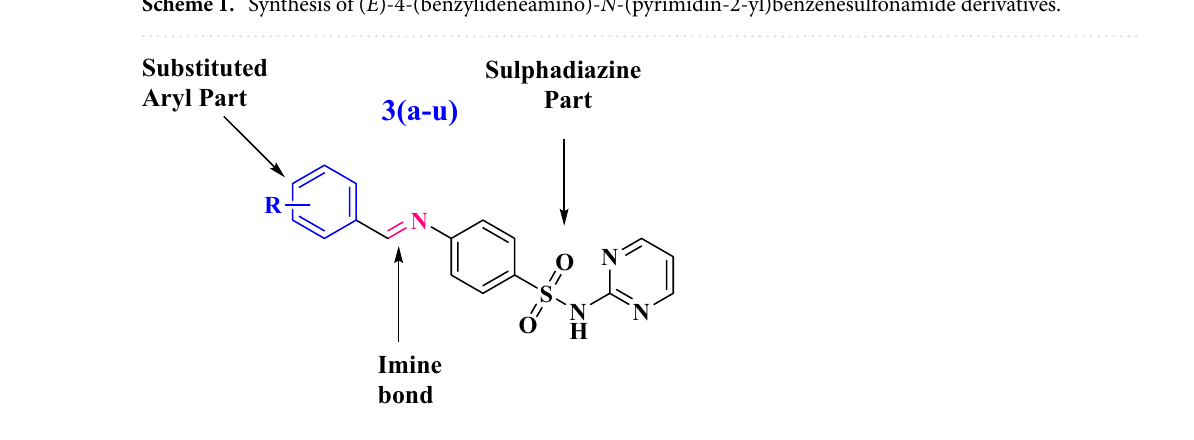
Figure 2. ( E )-4-(benzylideneamino)- N